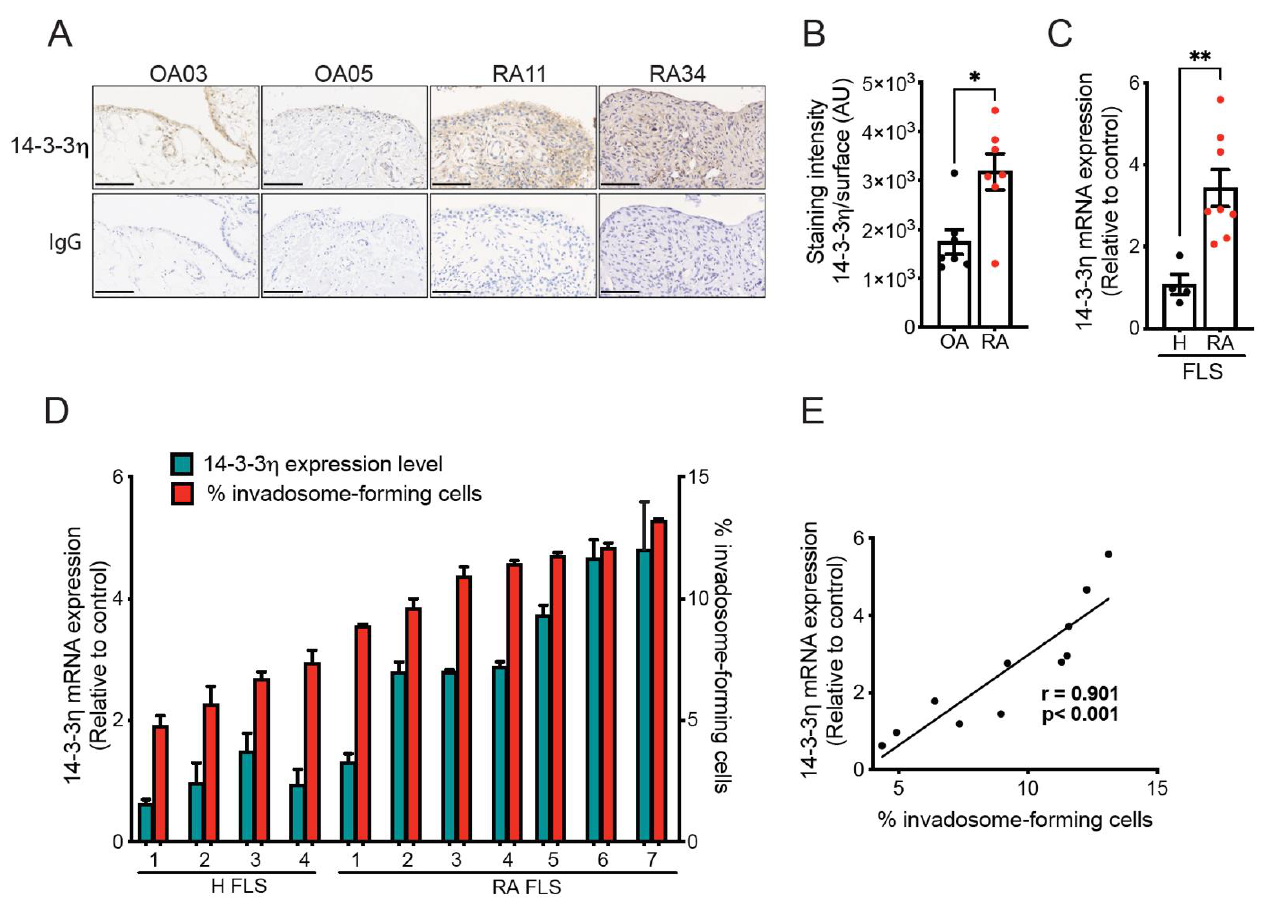
Figure 1. 14-3-3η expression in synovial tissue sections and primary cultures of H FLS and RA FLS. ( A ) Representative images (original magnification 40X) of 14-3-3η expression in paraffin-embedded synovial tissue sections from RA and OA patients (upper panel). Isotype matched control antibody (IgG) staining is presented in the lower panels. Scale bar = 100 µm. ( B ) The associated graph represents the intensity of labeling in arbitrary units (AU) for 7 OA and 8 RA patients. ( C ) RT-qPCR analysis of 14-3-3η mRNA expression in H FLS (from 4 healthy individuals) and RA FLS (from 7 RA patients) using RPLP0 as a reference gene. The results are expressed as mean mRNA expression relative to the control. ( D ) Relationship between 14-3-3η mRNA expression and invadosome formation in H FLS and RA FLS. H FLS (from 4 healthy individuals) and RA FLS (from 7 RA patients) were cultured on Oregon Green 488 -conjugated gelatin for 48 h, and the percentage of cells forming invadosomes was counted in 3 fields of 100 cells ( n = 2–4). mRNA expression was also analyzed via qPCR for matched cell lines. ( E ) The correlation between the 14-3-3η mRNA level and invadosome formation was evaluated using the Pearson’s correlation coefficient. Data represent the mean ± SEM * p < 0.05 and ** p < 0.01, unpaired t-test.